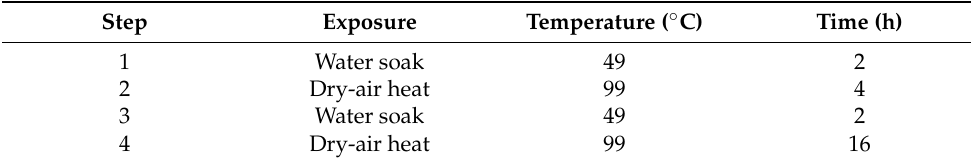
Table 1. Accelerated ageing steps for wood